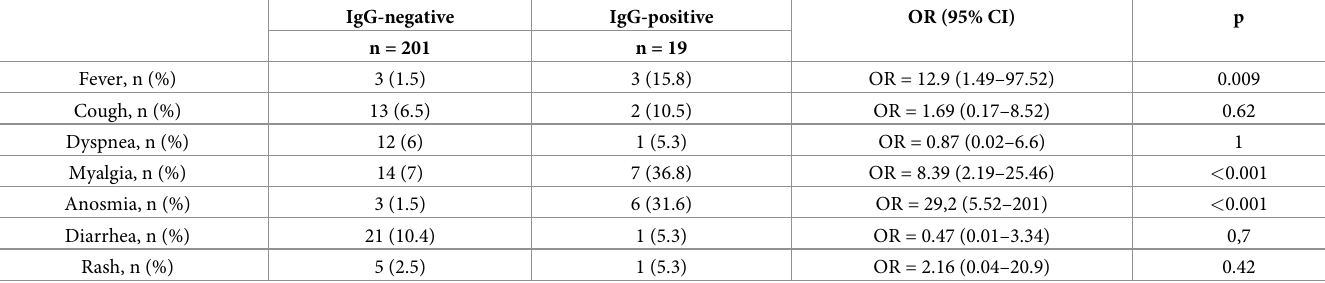
Table 2. Reported signs and symptoms according to SARS-CoV-2 serological status for women admitted for